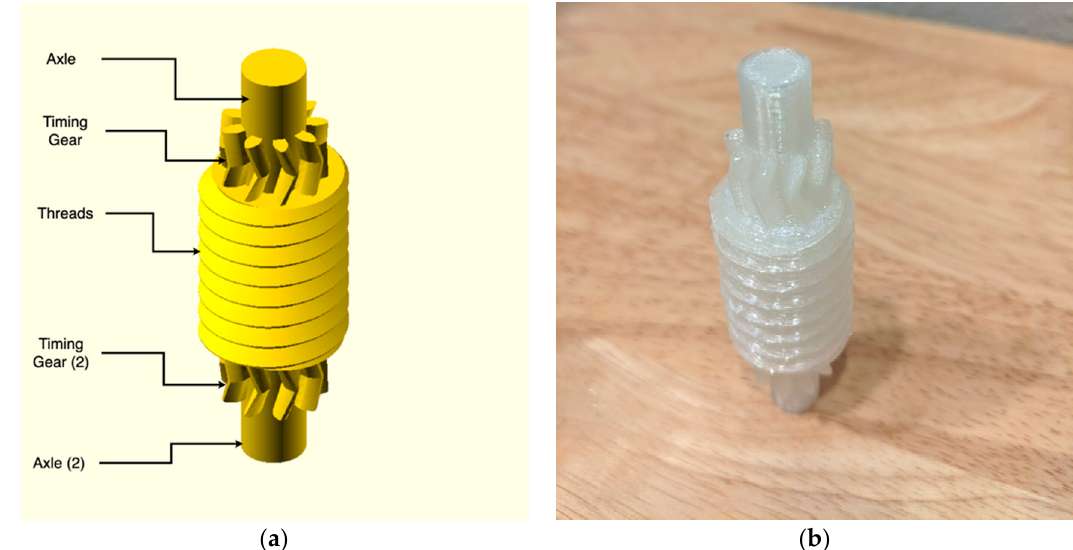
Figure A2. ( a ) Finished and labeled rendering of the roller assembly. ( b ) Three-dimensional (3D)-printed roller assembly. Printed on an open source PrusaMK3S with natural PLA at 0.2 mm layer height. Printed in orientation shown with support material around bottom overhang.